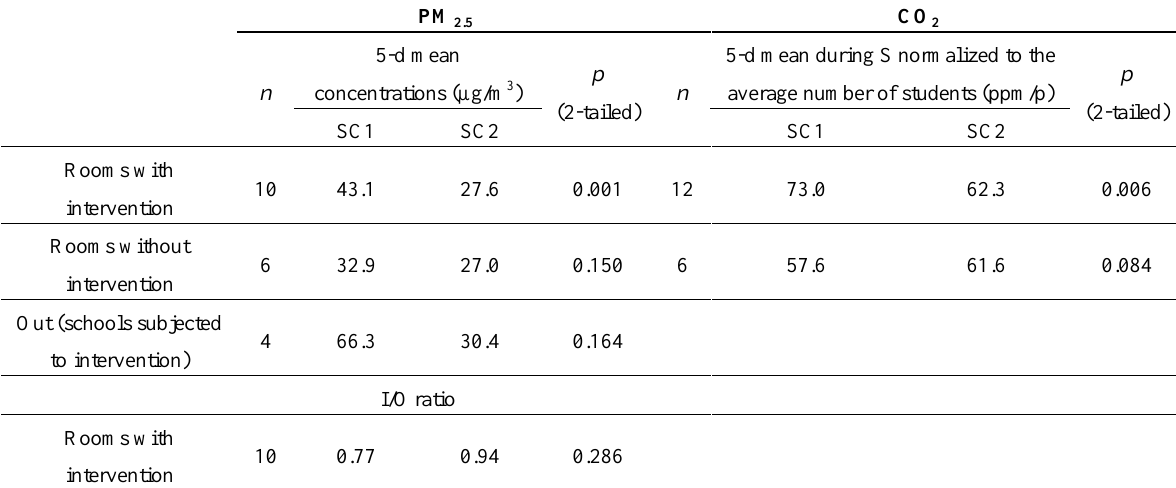
Table 6. Results of paired t -tests between pre- and post- intervention indoor PM 5-d